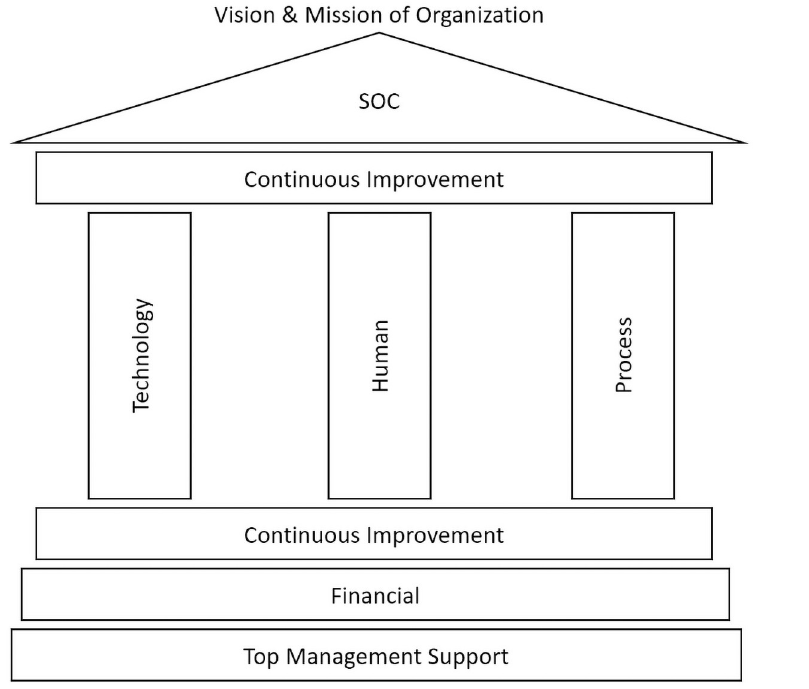
Fig 3. Model for the development and implementation of the